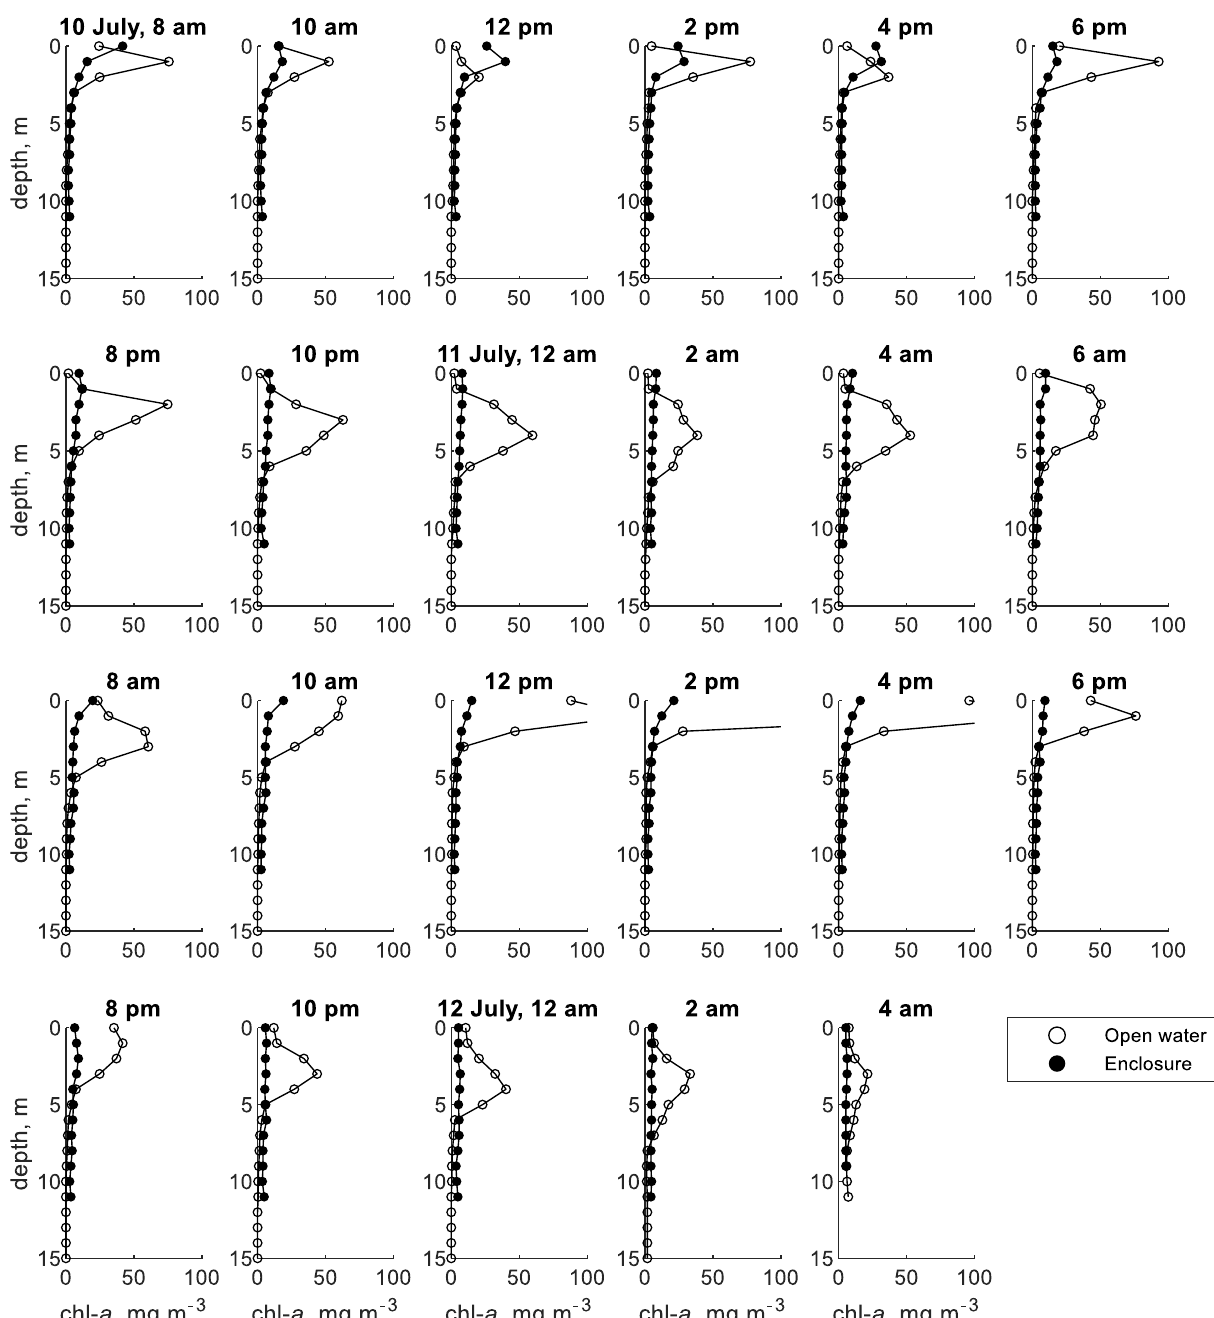
Figure 2. Chlorophyll a concentration profiles measured in Shennong Stream enclosure and open water sites; data extracted from Cui et al. [12].